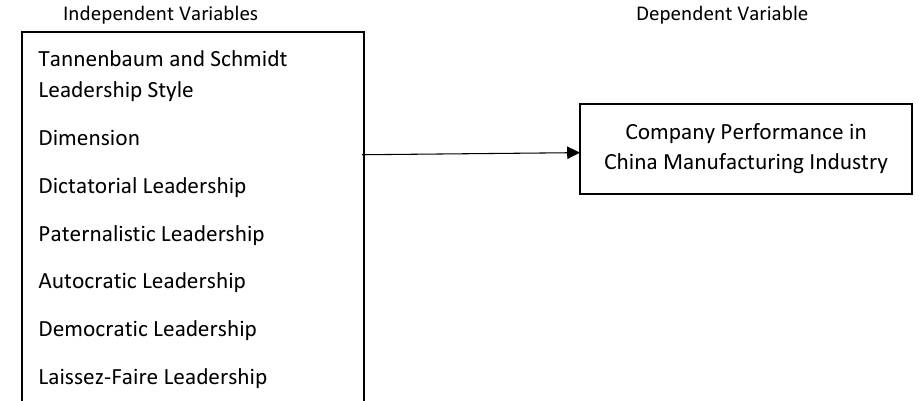
Fig. 1: Leadership style and company performance in the manufacturing industry